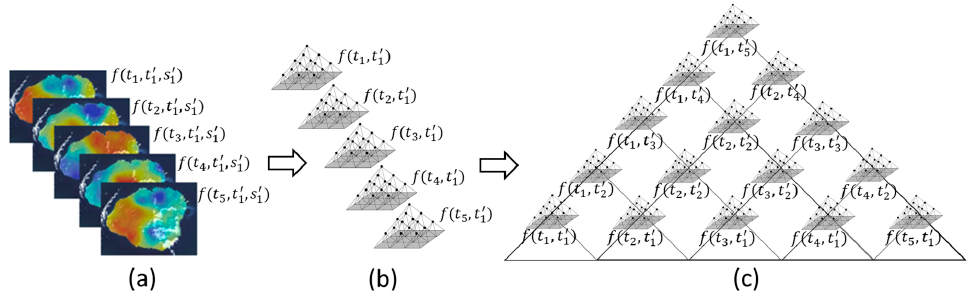
Figure 19. The representation of multi-scale spatio-temporal data in the continuous spatio-temporal model (CSTM). ( a ): Time series of spatial data. ( b ): Time series of PMs. ( c ): PMs of different time intervals in a TM.